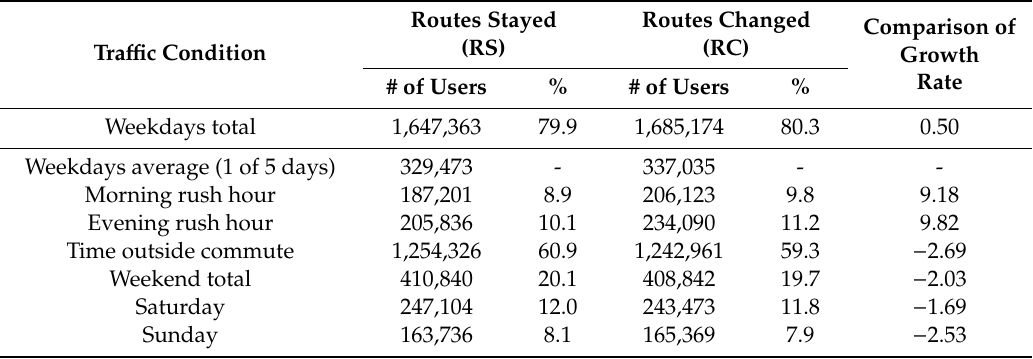
Table 9. Classification by bus combination and tra ffi c